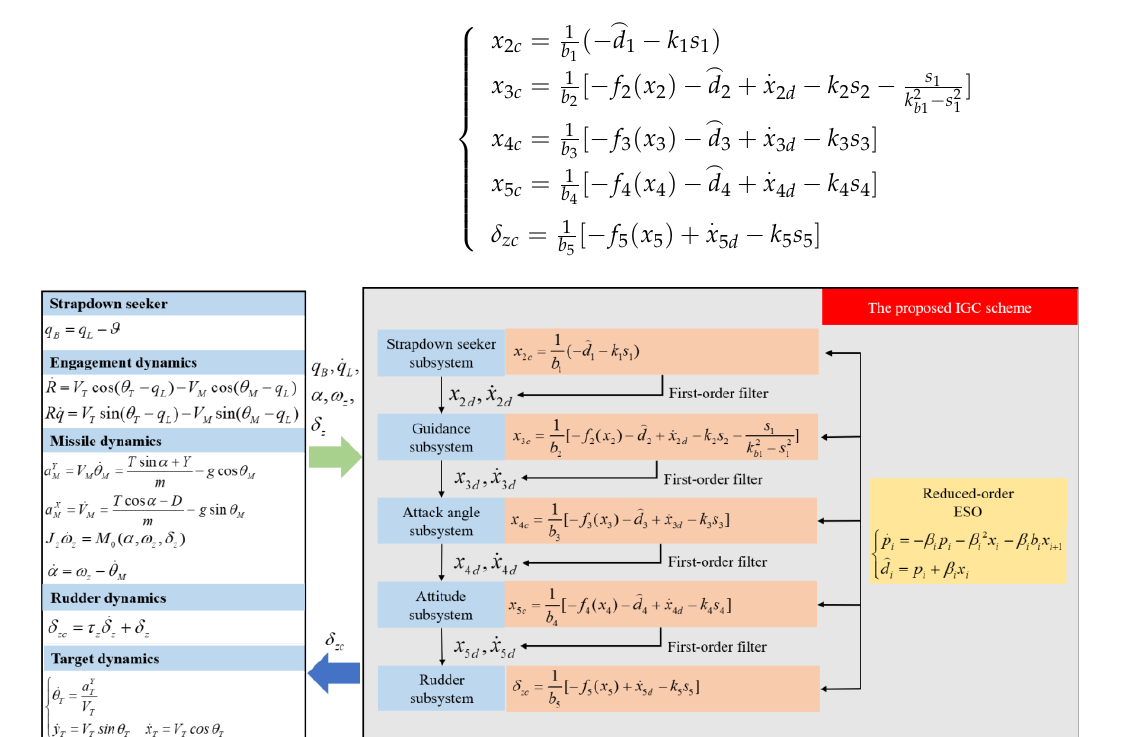
Figure 2. Configuration of the proposed IGC law based on BC with BLF and SMC.